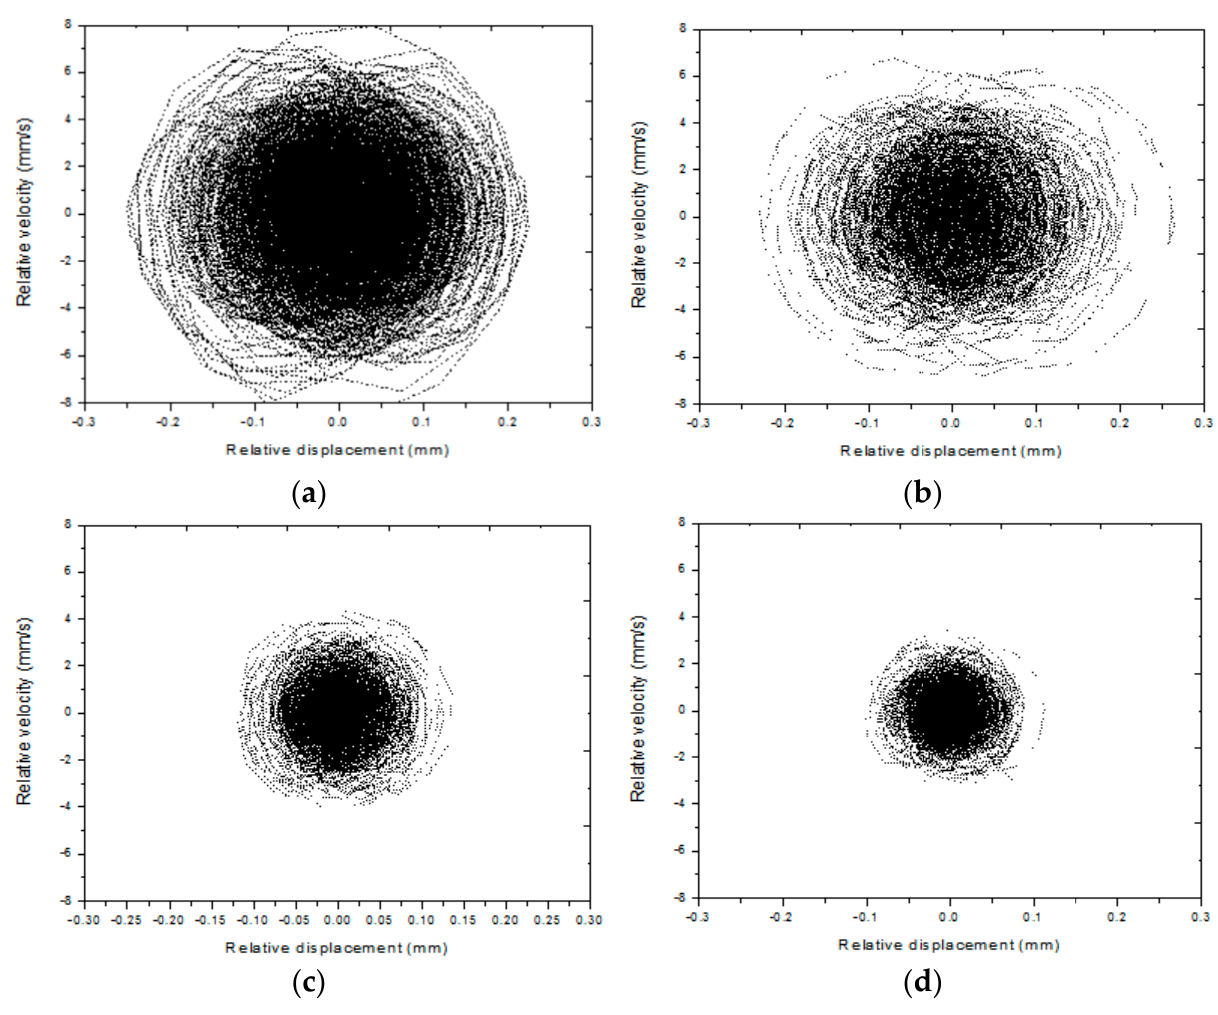
Figure 10. Relative Phase-Plane Curves of “Adjacent” Measuring Points at Soil-Pile Interface under White Noise: ( a ) Before earthquake, ( b ) After earthquake of small level, ( c ) After earthquake of medium level, ( d ) After earthquake of high level.